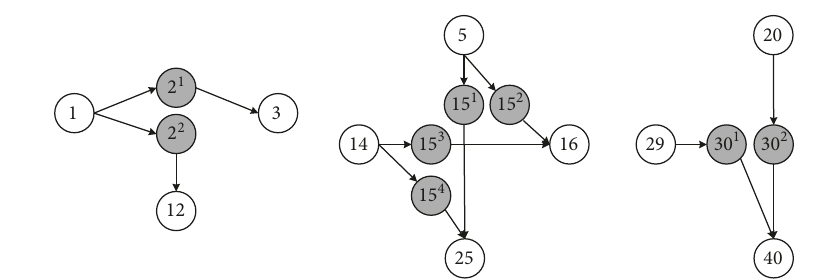
Figure 9: The spilt signal phase nodes (take nodes 2, 13, and 30 as an example).